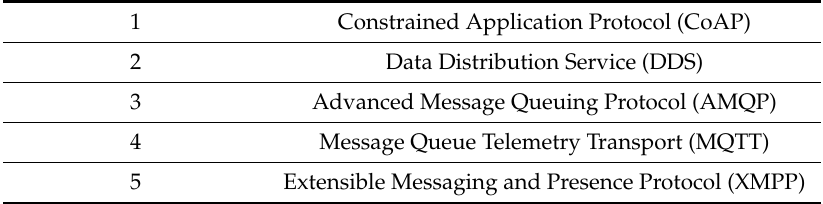
Table 2. List of Application Layer Protocols for